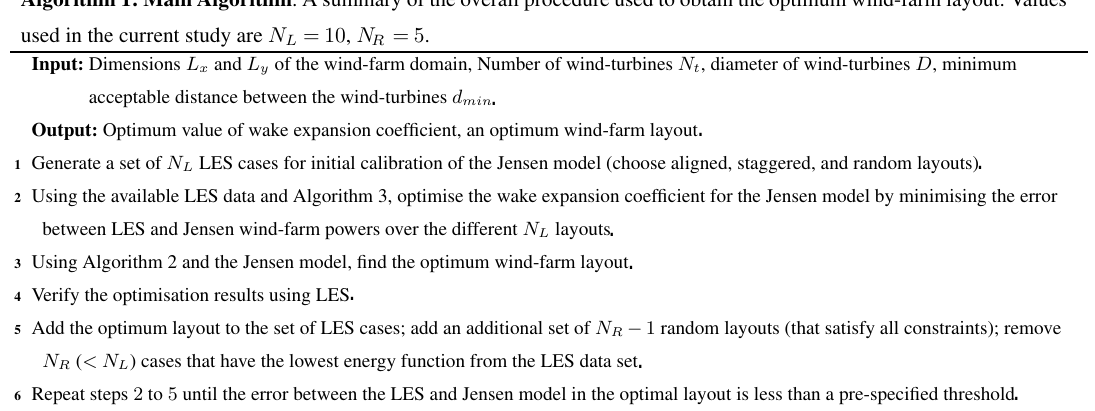
Algorithm 1: Main Algorithm . A summary of the overall procedure used to obtain the optimum wind-farm layout. Values used in the current study are N L = 10 , N R = 5 .